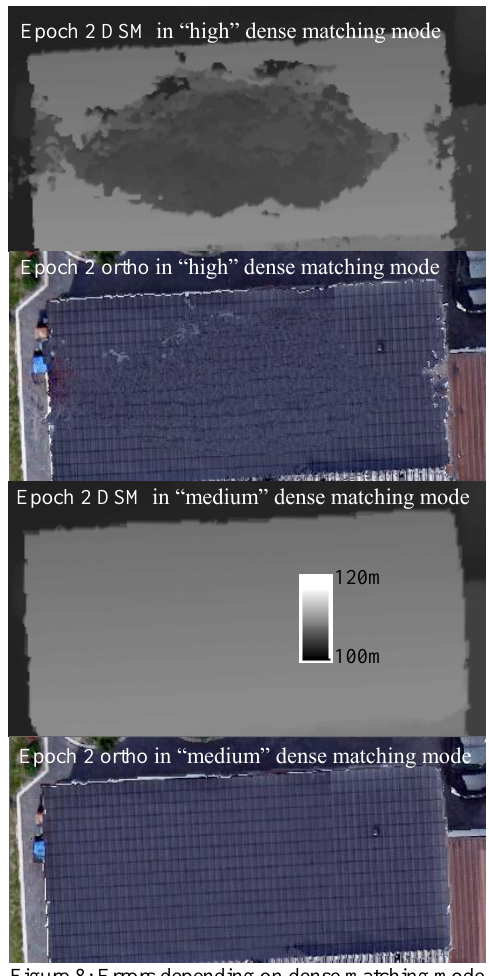
Figure 8: Errors depending on dense matching